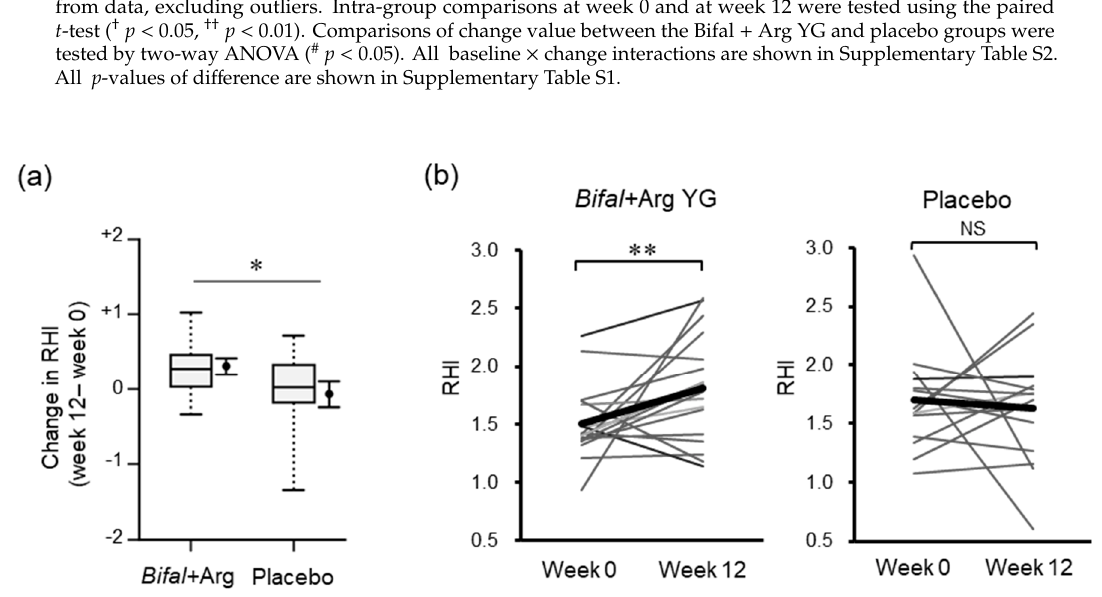
Table 1. Characteristics of subjects’ background and effects of yogurt containing B. animalis subsp. lactis and arginine on physical parameters, RHI, and blood pressure.